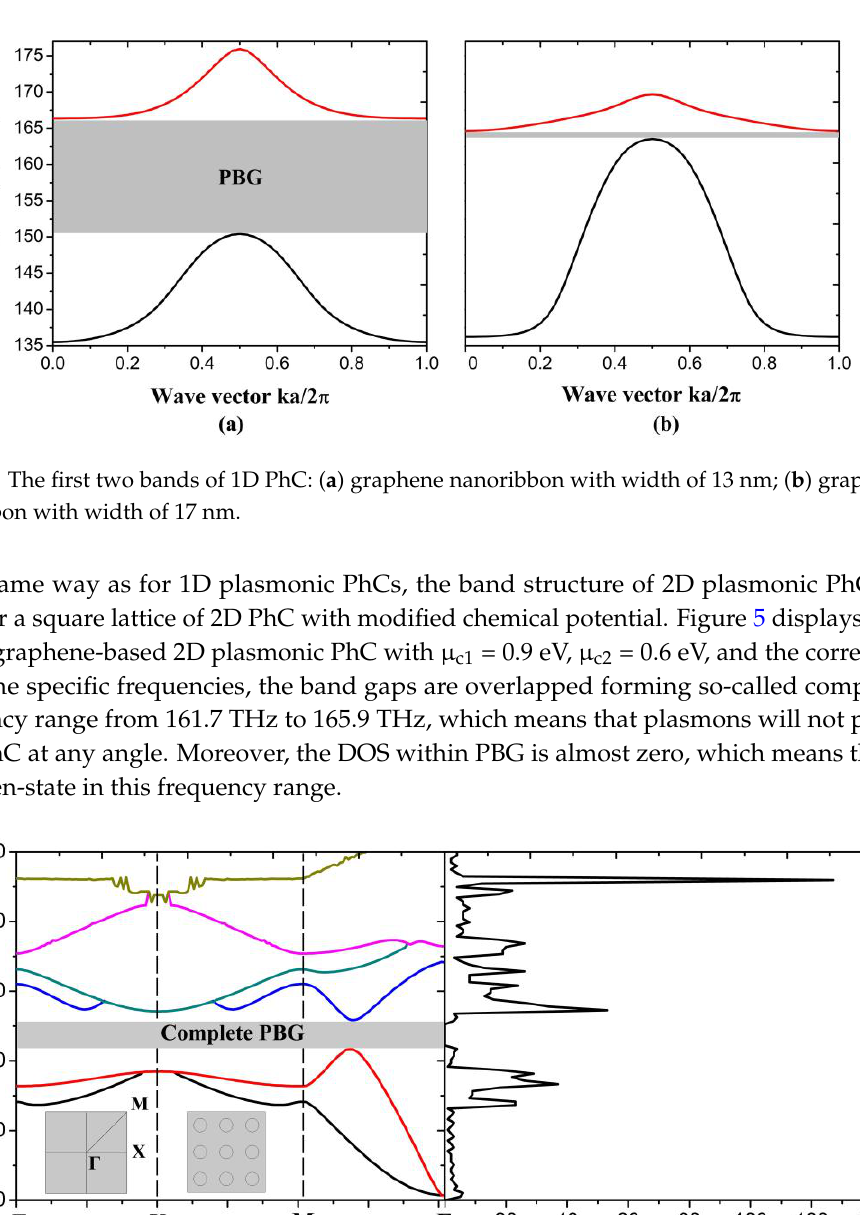
Figure 5. Band structure ( left ) and DOS ( right ) of graphene-based plasmonic 2D PhC with lattice constant a = 20 nm. The left inset shows the Brillouin zone, with the irreducible zone from 𝛤 to X to M. The right inset shows a view of the periodically modified chemical potential with μ c1 = 0.9 eV, μ c2 = 0.6 eV, and circular radius r = 5 nm.